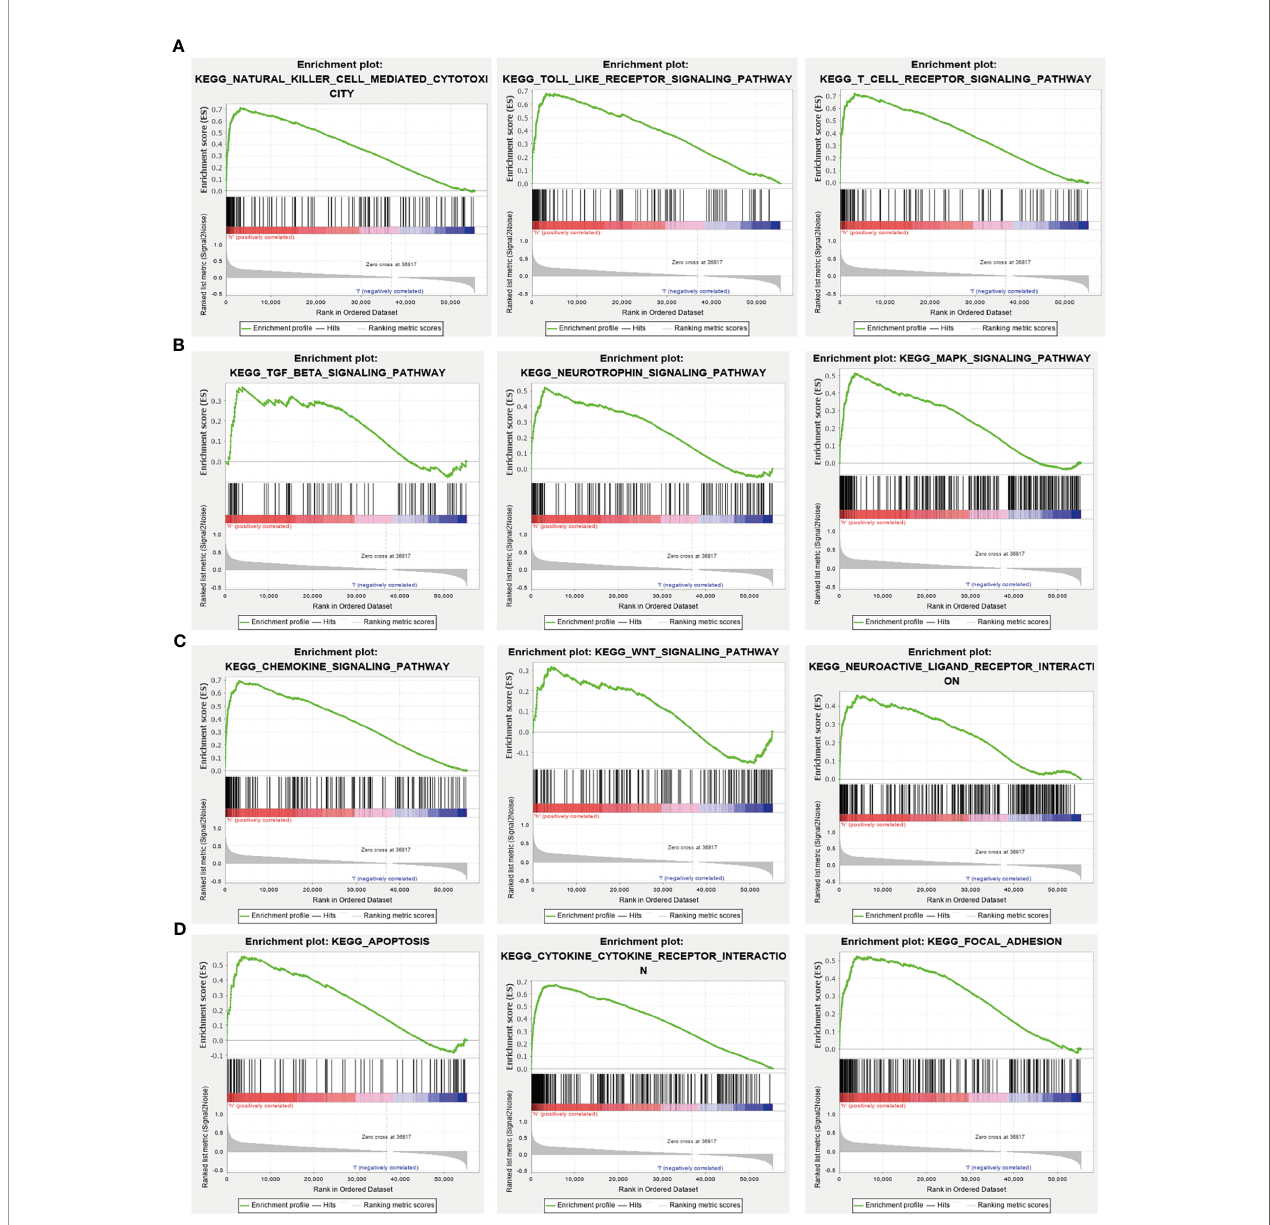
FIGURE 6 | KEGG signaling pathway analysis using GSEA tools. (A – D) The involvement of genes coexpressed with NCAPG in glioma signaling pathways as examined by GSEA